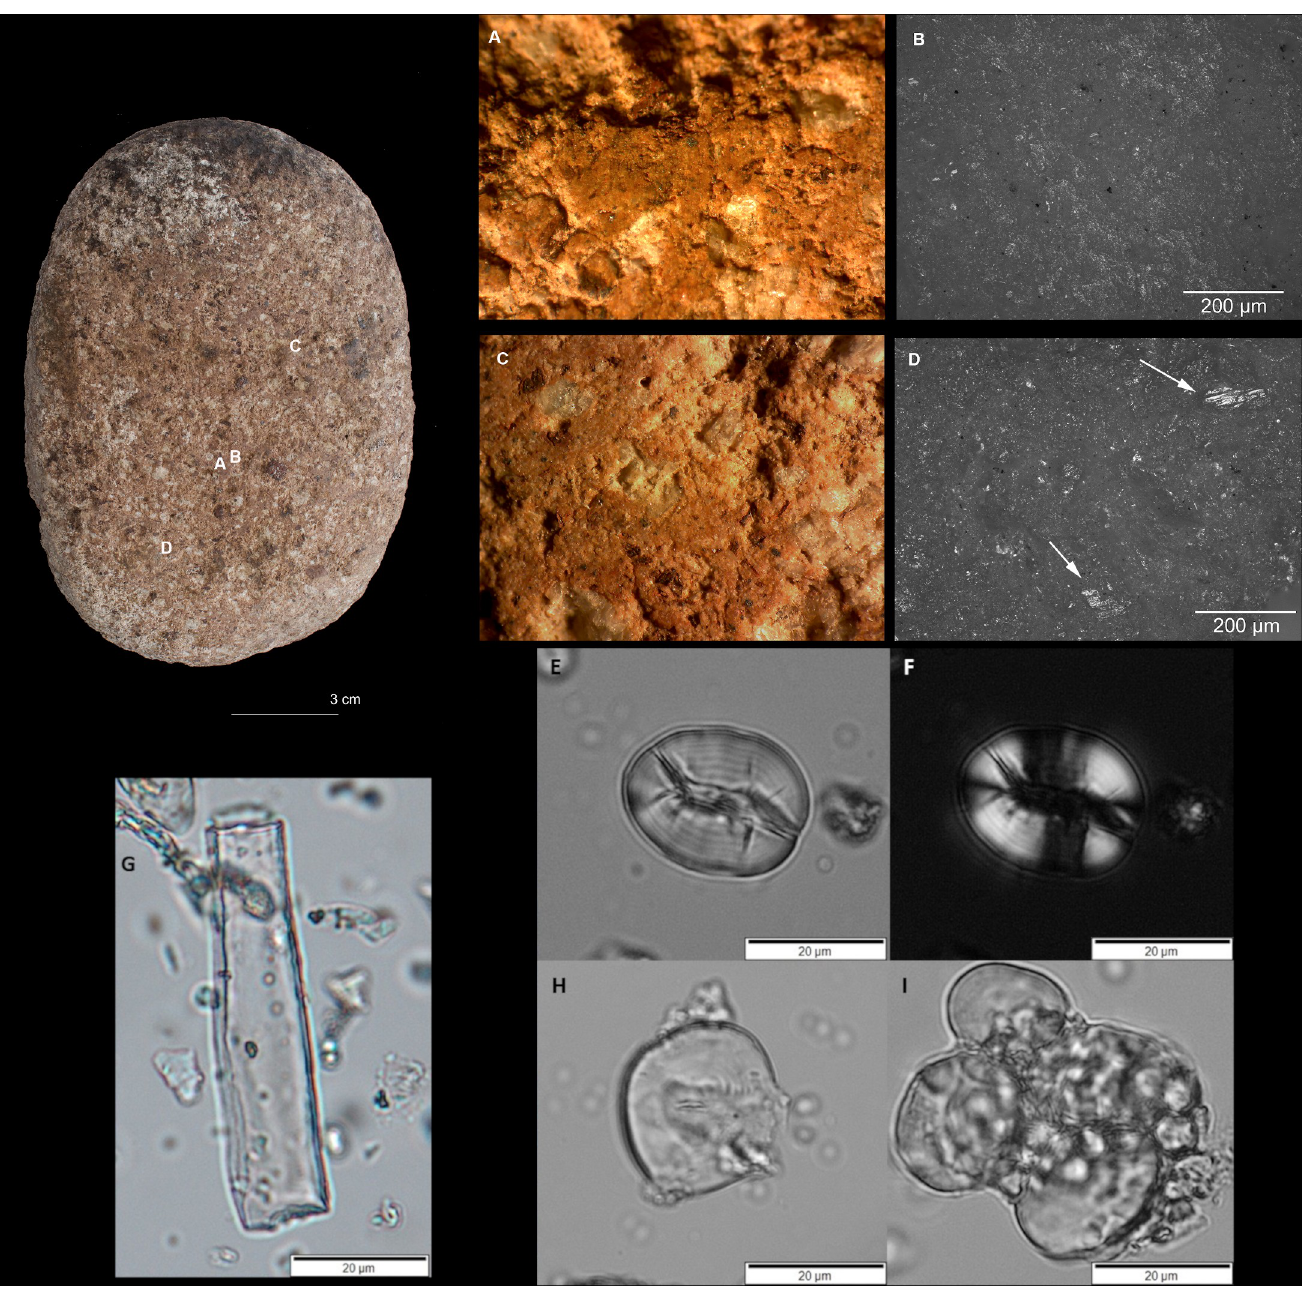
Fig 12. Microwear traces and microbotanical residues on the use-face of grinder 10292.x2. A) levelling of grains (magnification 30x); B) plant (legumes) micropolish; C) low power observations levelling of grains (magnification 20x); D) plant (legumes) micropolish and; G) Elongate smooth psilate phytolith; H) Triticeae starch grain damaged by pressure; I) Triticeae starches aggregate. Microbotanical pictures at 400x magnification. texture and pitted appearance that develops in patches of random disposition. Microstriations accompany the micropolish. The mineral micropolish identified on this tool does not resemble the striated micropolish that is associated with the stone on stone contact usually seen on grinding tools. In addition, a granular, reflective and rough micropolish that has a reticular distribution and forms distinctive patches is present on the tool use-face. In places, localized